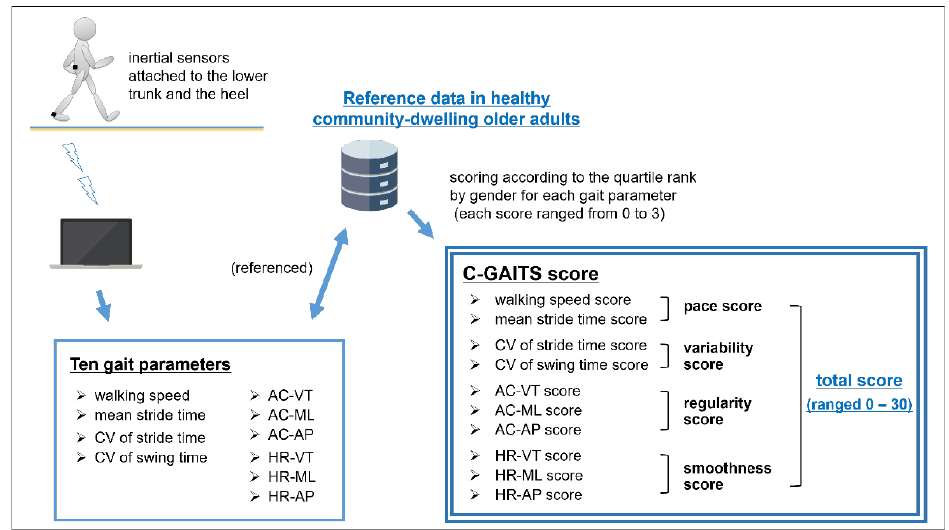
Figure 1. Overview of the Comprehensive Gait Assessment using the InerTial Sensor score (C-GAITS score).